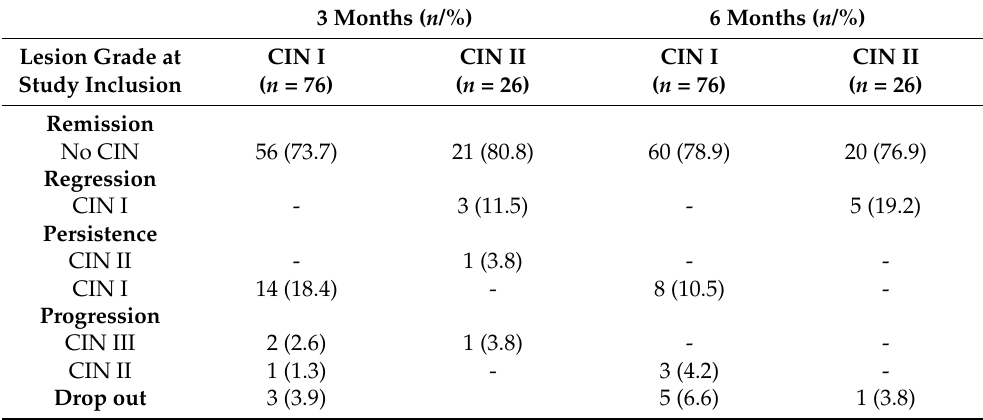
Table 3. Histopathologic response rates (remission and regression) of patients with cervical in- traepithelial neoplasia grade I and II 3 and 6 months after a single topical treatment with 85% trichloroacetic acid. 3 Months ( n /%) 6 Months ( n